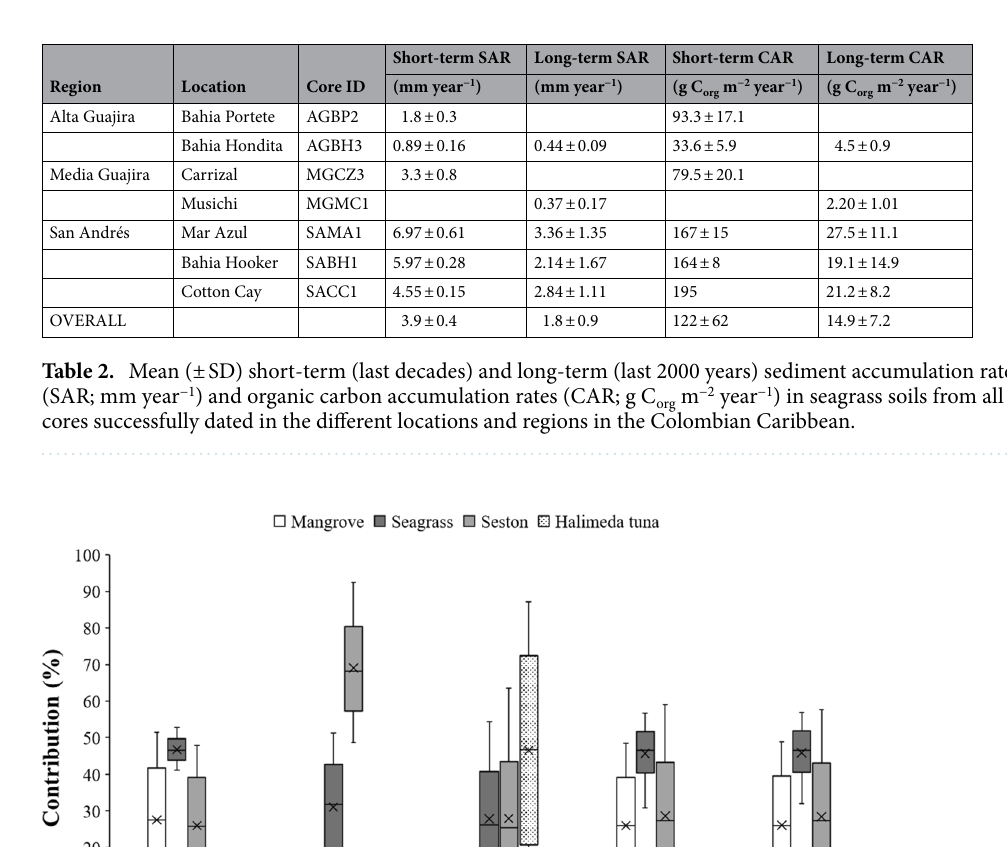
Table 1. Mean (± SD) dry bulk density (g cm −3 ), organic carbon content (C org , %), organic matter content (OM, %), δ 13 C (‰), sediment grain-size < 0.016 mm, > 0.0.016 < 0.125 mm and > 0.5 mm (%) and soil organic carbon stocks (in 1 m-thick, kg C org m −2 ) in seagrass soils from all cores studied in the different locations and regions in the Colombian Caribbean.